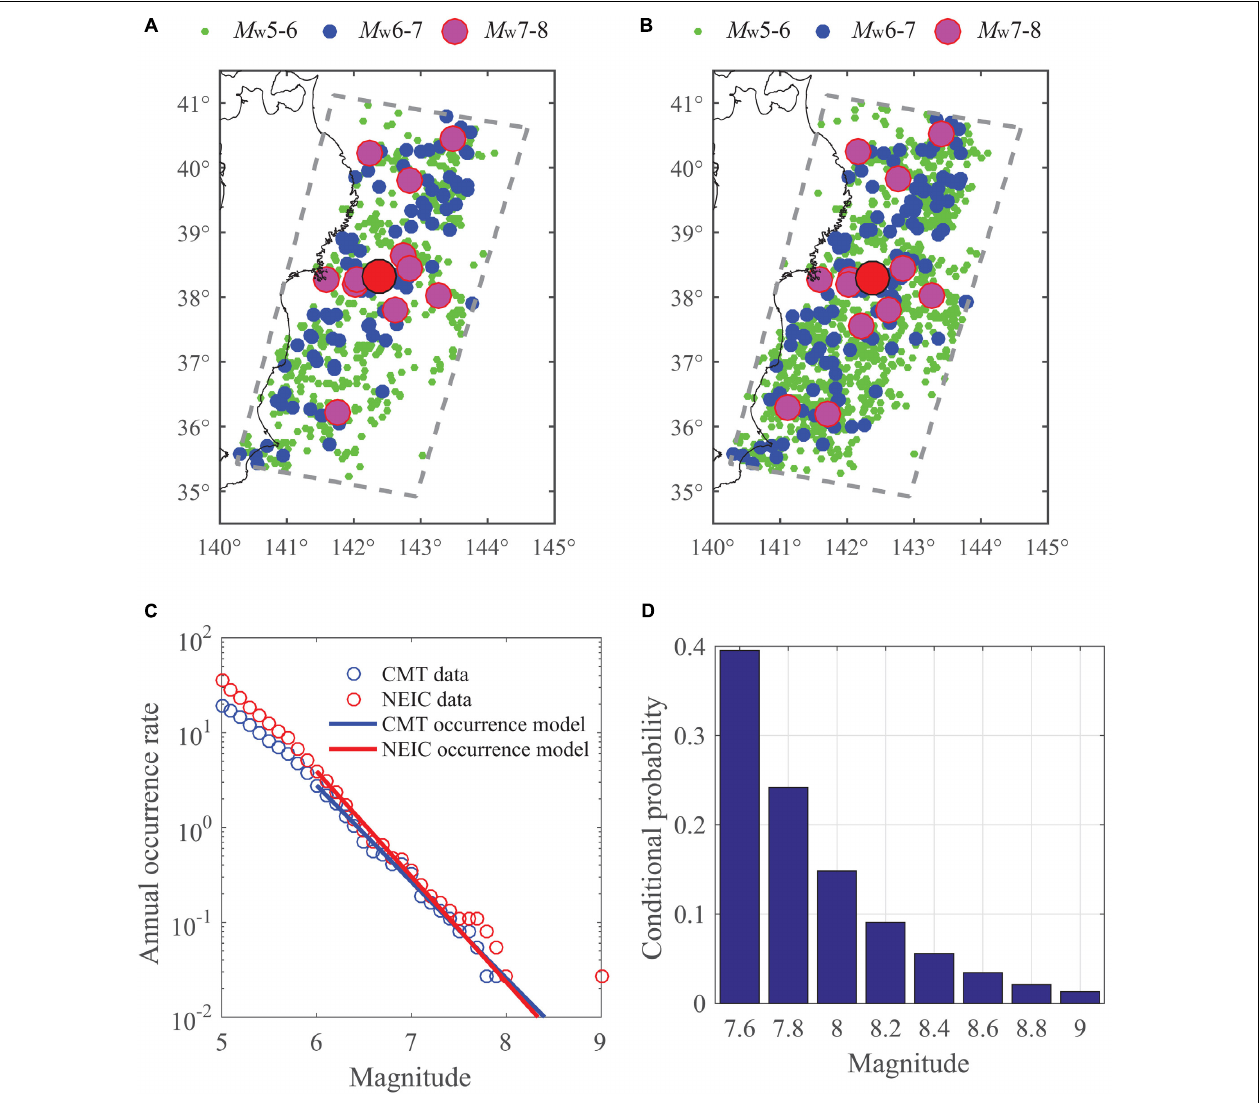
FIGURE 1 | Earthquake source of the off-Tohoku region: (A) Harvard CMT earthquake catalog, (B) NEIC earthquake catalog, (C) Gutenberg-Richter relationships based on the Harvard CMT and the NEIC catalogs, and (D) conditional probability distribution of earthquake magnitudes ≥ M w